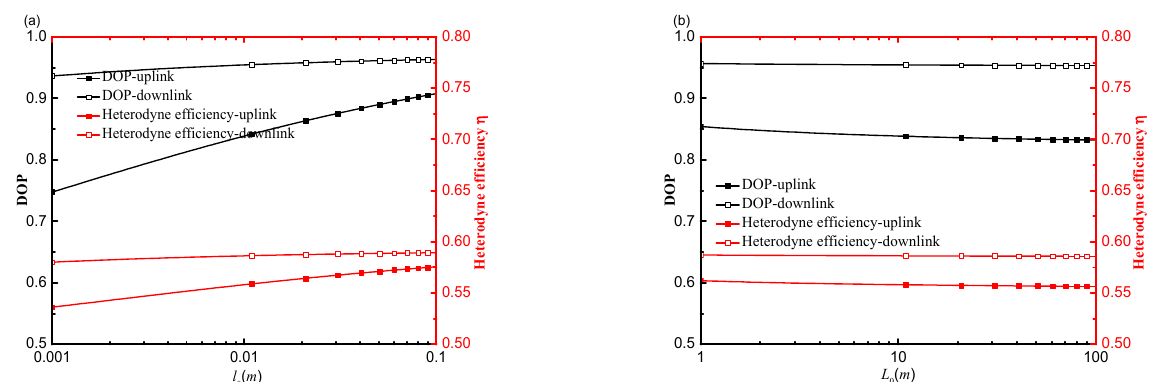
Figure 6. Effect of inner scale and outer scale on the heterodyne efficiency and DoP on an uplink path and a downlink path in atmospheric turbulence, ( a ) l 0 ( b ) L 0 . Heterodyne efficiency and DoP are shown in Figure 7a–c as a function of transmis- sion distance z for various refractive index structure parameters. As shown in Figure 7a~c, the heterodyne efficiency and DoP of an uplink path and a downlink path are extremely similar within a transmission distance of 100 m. This is because, when the transmission distance is relatively small, the random fluctuation carried upon by the refractive index may be omitted. The maximum DoP and heterodyne efficiency of a downlink propagation path correspond to a transmission distance that is greater than an uplink propagation path, and it decreases with an increasing atmospheric refractive index structure constant C 2 10 − 16 m − 2/3 to 10 − 12 m − 2/3 . As the transmission distance increases, the DoP and heterodyne n efficiency of a downlink path are significantly impacted by strong atmospheric turbu- lence, as compared to weak and medium-strong atmospheric turbulence intensities. This is due to the fact that when the number of small-scale gyres increases in the area of con- siderable atmospheric turbulence, the diffraction of the signal beam is strengthened, which is consistent with the findings in Figure 6.